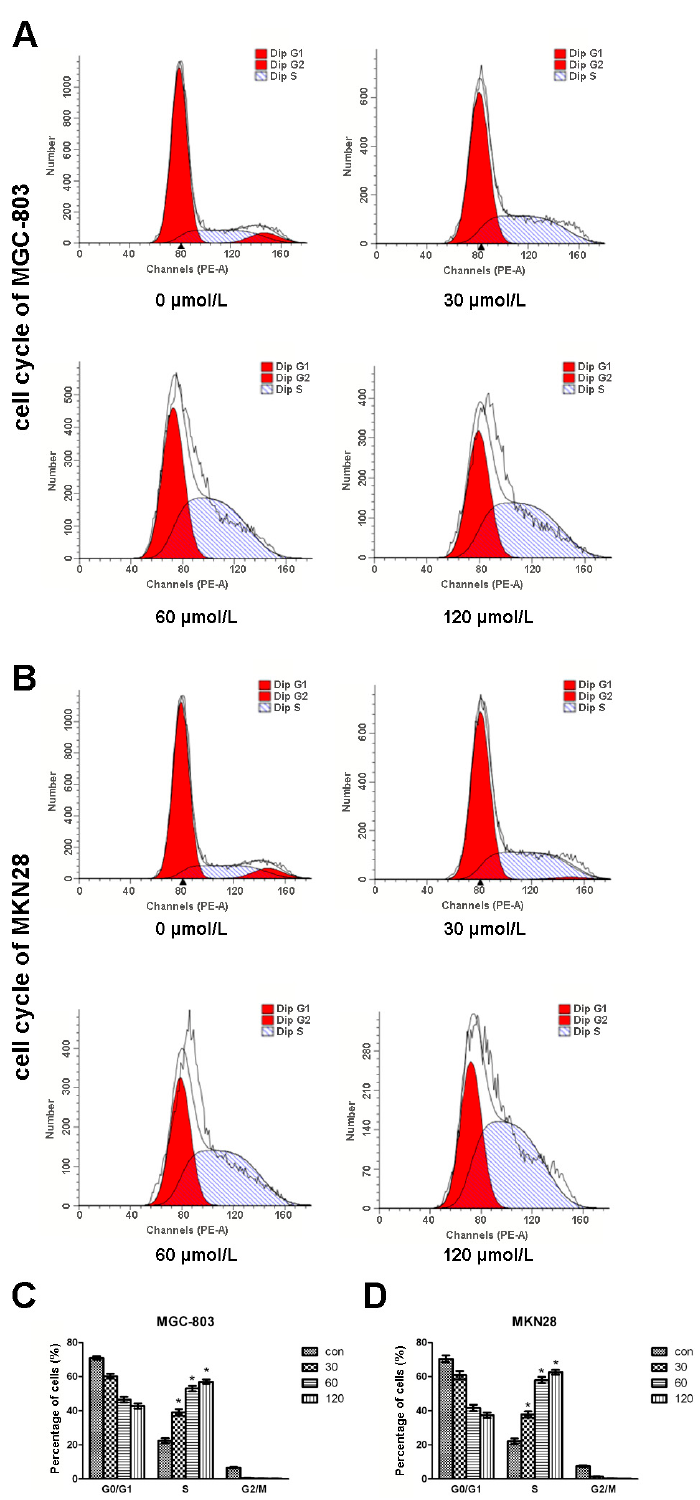
Figure 2. CVB-D arrests cell cycle progressions of MGC-803 and MKN28 cells. ( A , B ) Representative graphs of flow cytometry analysis of cell cycle stages of CVB-D (0, 30, 60 and 120 µmol/L) treated MGC-803 ( A ); and MKN28 cells ( B ); ( C , D ) Statistic analysis of cells numbers at G 0 /G 1 , S and G 2 /M stages of CVB-D treated MGC-803 ( C ); and MKN28 cells ( D ). * p < 0.05. Each experiment included at least three replicates.